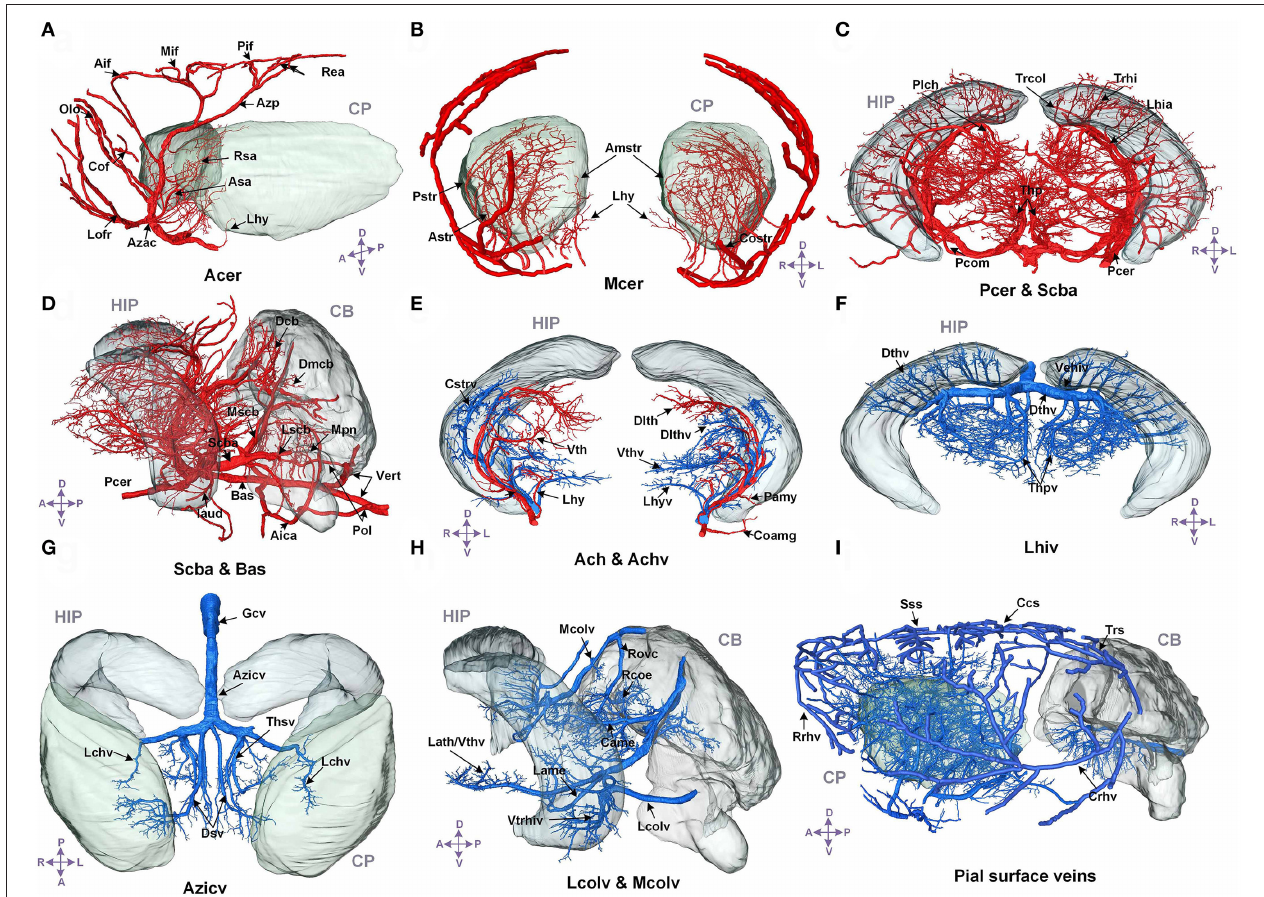
FIGURE 3 | The structure, distribution and labeling of the whole brain vascular system of different arteries and veins in 3D. Red indicates arteries, and blue indicates veins. The vascular names are all marked in black. The names of brain regions are marked in gray. (A) The distributions of Acer and its major branches are mainly located between the CP. (B) The distributions of Mcer and its major branches, which mainly extend into the CP and the outside of the pial surface. (C) The distributions of Pcer and its major branches, which mainly penetrate the HIP and TH below the HIP. (D) The distributions of Pcer and Vert and their major branches. The annotated branches of Vert mainly extend to both the surface and interior of the CB, P, and MY. (E) The distributions of Ach and Achv and their major branches, which are located in the rostral area of the HIP. (F) The distributions of Lhiv and its branches, which penetrate into the upper portion of the HIP and TH below the HIP. (G) The distributions of the thalamostriate vein (Thsv) and Gcv inside the brain, which extend to the caudal part of the CP and the rostral part of the TH along the middle area of the HIP. (H) The distributions of Mcolv and Lcolv and their branches. Mcolv is mainly located in the rostral aspect of the CB and the lateral aspect of the MB below the HIP, whereas Lcolv penetrates the lower portion of the HIP. (I) The distributions of the pial surface veins and the connected cortical penetrating veins. The penetrating veins presented here extend to the subcortical area. The list of abbreviations and full names of the brain regions is presented in Supplementary Table 1, and the tree of abbreviations and full names of the vessels is presented in Figure 4 . D, Dorsal; V, ventral; L, left; R, right; A, anterior; P,